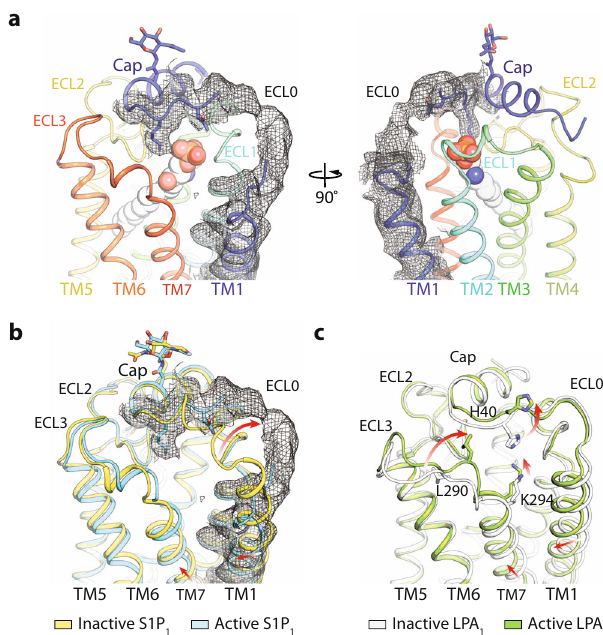
Fig. 4 The ECL movement during the activation. a , b The density overlaid with the model of active S1P 1 compared to inactive S1P1. c The model of active LPA 1 compared to inactive LPA 1 . The movement is indicated by red arrows, and key residues are shown in